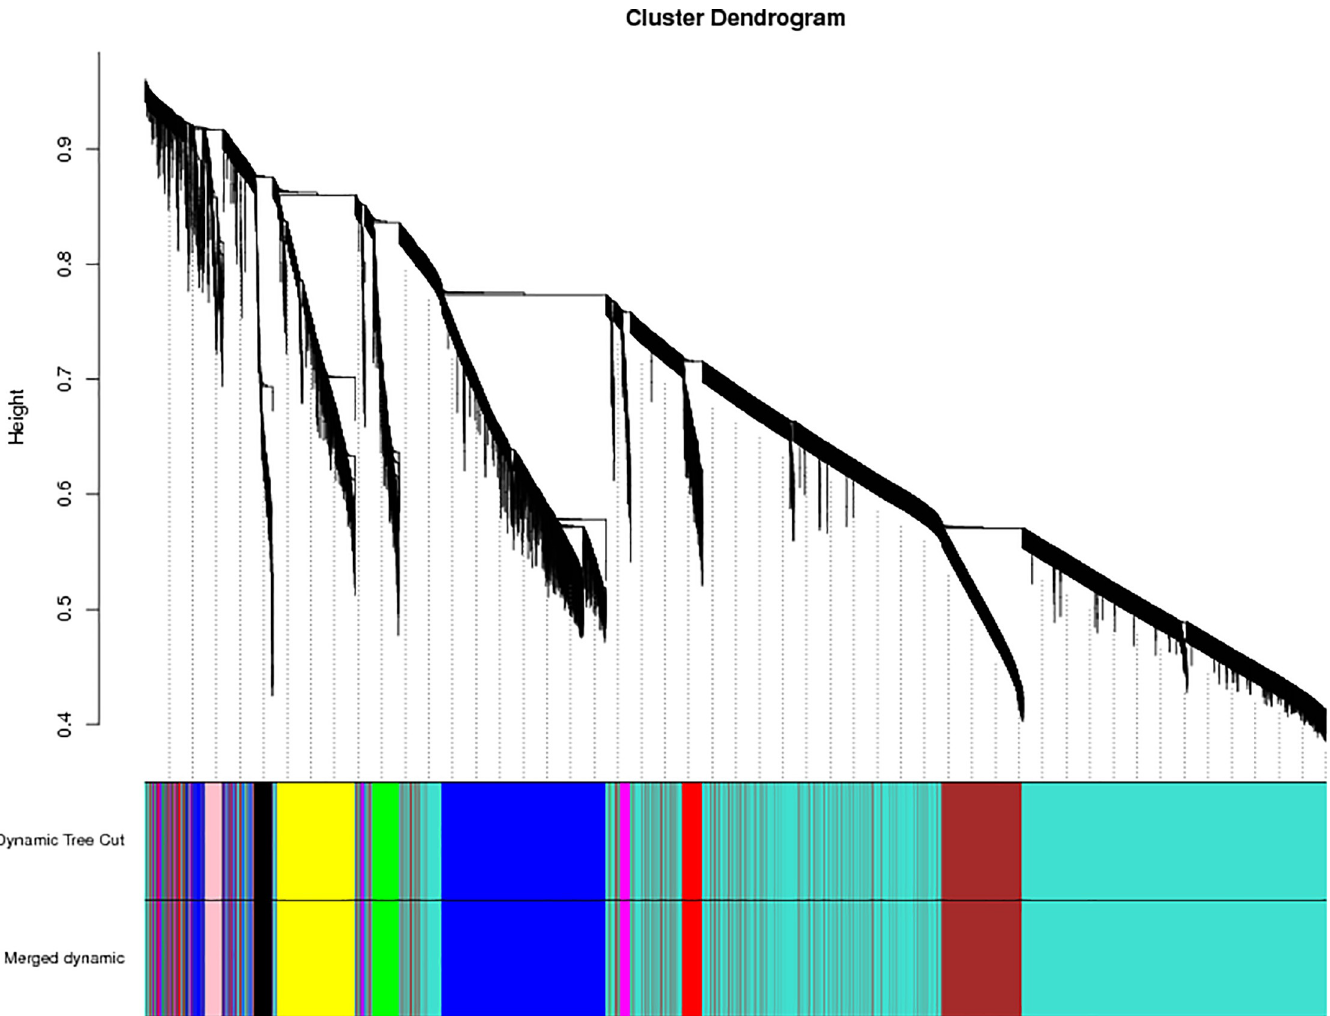
Fig 3. Module hierarchical clustering tree. Dynamic tree cut indicates module divided according to clustering results; merged dynamic indicates module divided according to similarity of the module. Analysis was carried out according to the merged module. Vertical distance in tree diagrams represents distance between two nodes (between genes); horizontal distance is